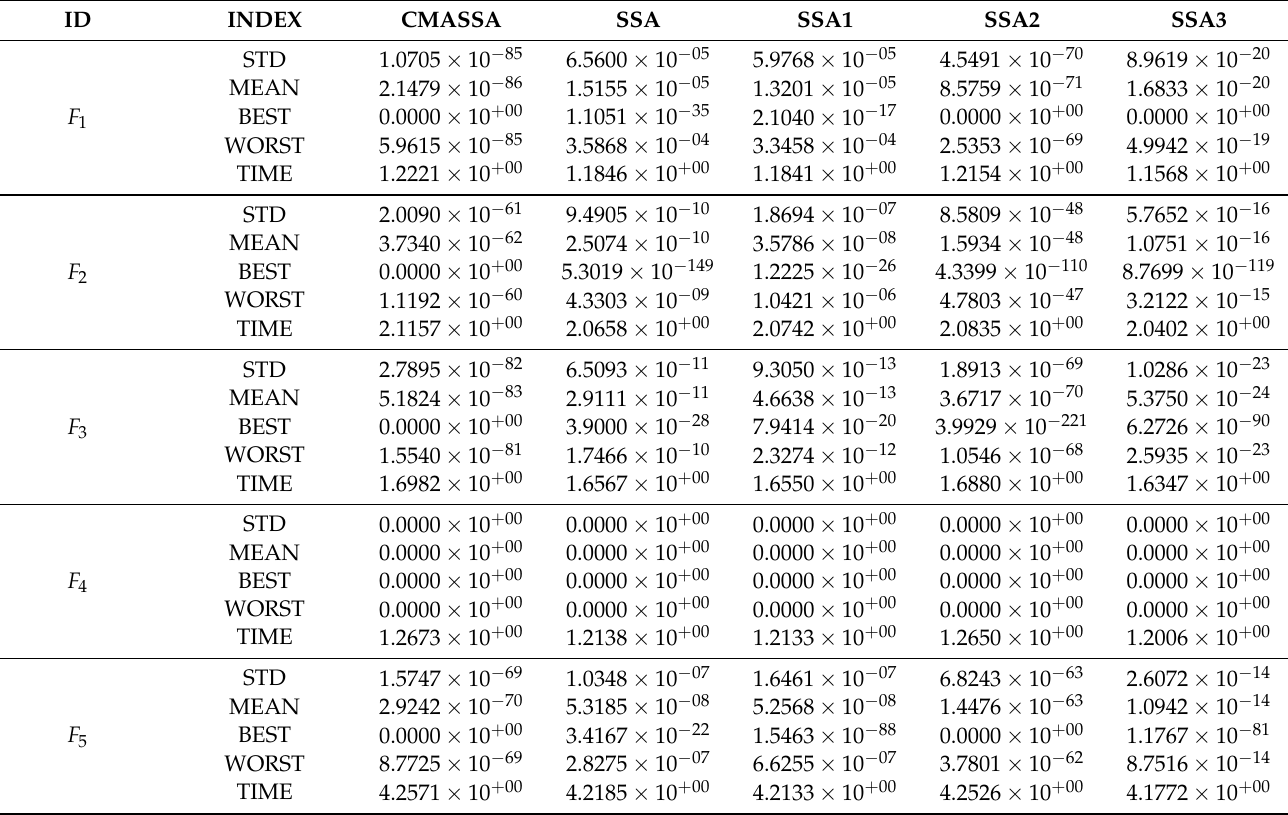
Table 2. Ablation experiment comparison